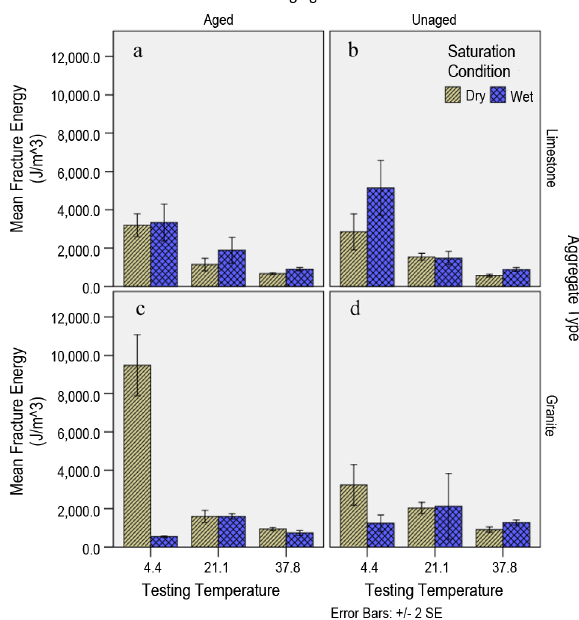
Fig. 6. Fracture energy of: a) limestone aged mixtures; b) limestone un-aged mixtures; c) granite aged mixtures;